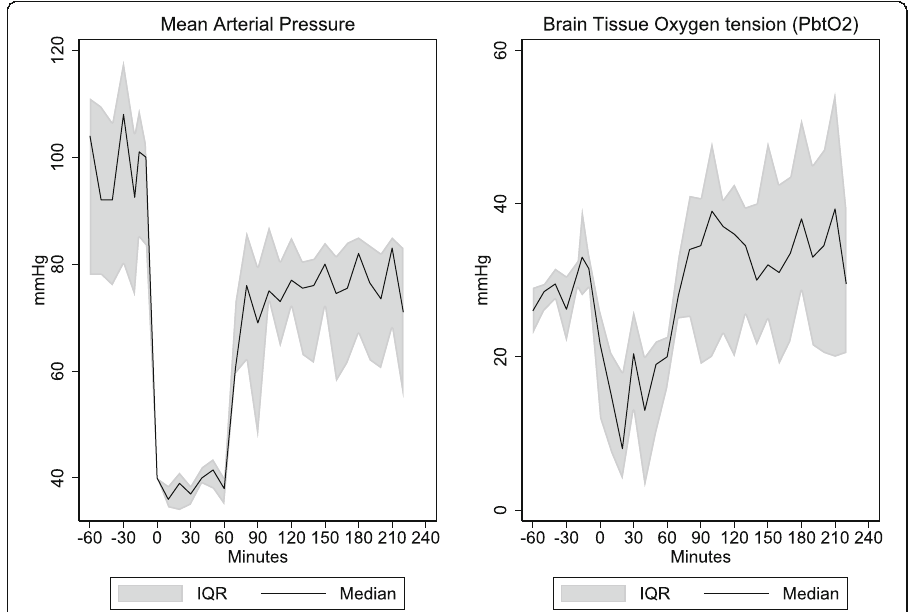
Fig. 2 Mean arterial pressure and brain tissue oxygen tension. Median (interquartile range) arterial pressure (MAP) and brain tissue oxygen tension (PtbO2) in pigs ( n = 9) with induced hemorrhagic shock. Note that during the period of hemorrhagic shock the declining MAP was accompanied by a decrease in PbtO 2 near critical levels (< 15 mmHg). After re-infusion of autologous blood MAP increased to close to baseline level whereas PbtO 2 increased to levels above baseline. Time 0 indicates achievement of MAP equal to 40